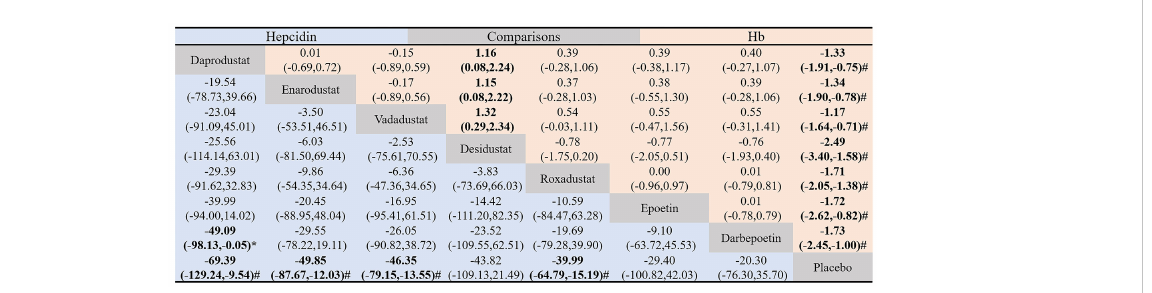
FIGURE 5 Pairwise comparison of the hepcidin-lowering and hemoglobin-raising effectiveness of the eight drugs included in the study. Data in each grid represent MD and 95% CI. Column-de fi ning drugs are compared to the row-de fi ning drugs. The lower triangle (blue) shows pairwise comparisons of the effectiveness of hepcidin-lowering among the eight interventions, and the upper triangle (red) shows pairwise comparisons of the effectiveness of hemoglobin-raising among the eight interventions. The Difference between the two interventions was considered statistically signi fi cant when the 95% CI for MD did not include 0. #, signi fi cant difference compared to placebo. *, signi fi cant difference compared to ESAs.